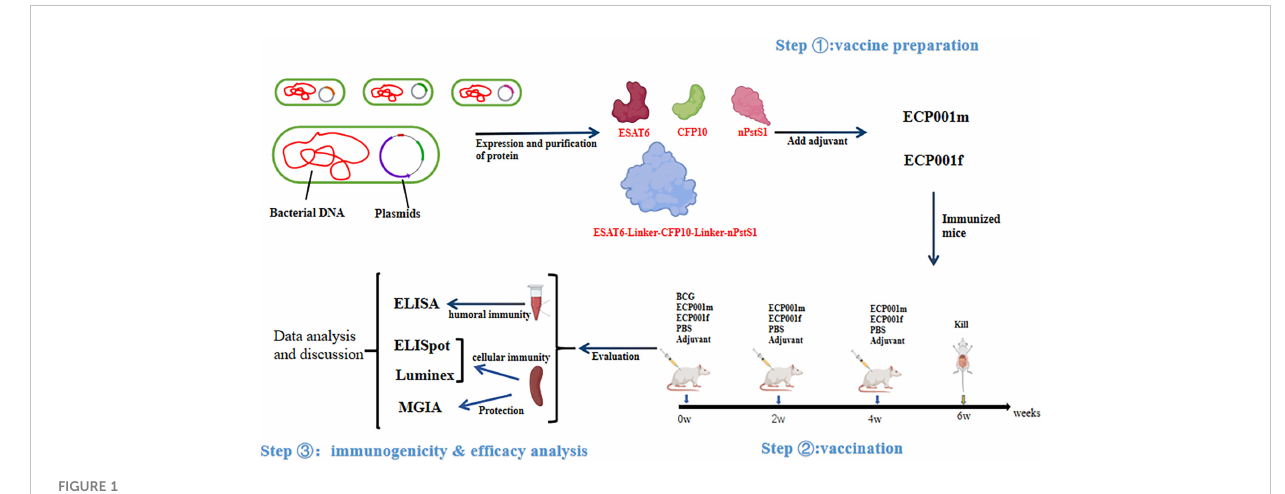
FIGURE 1 Schematic diagram of experimental design and procedures in this study.